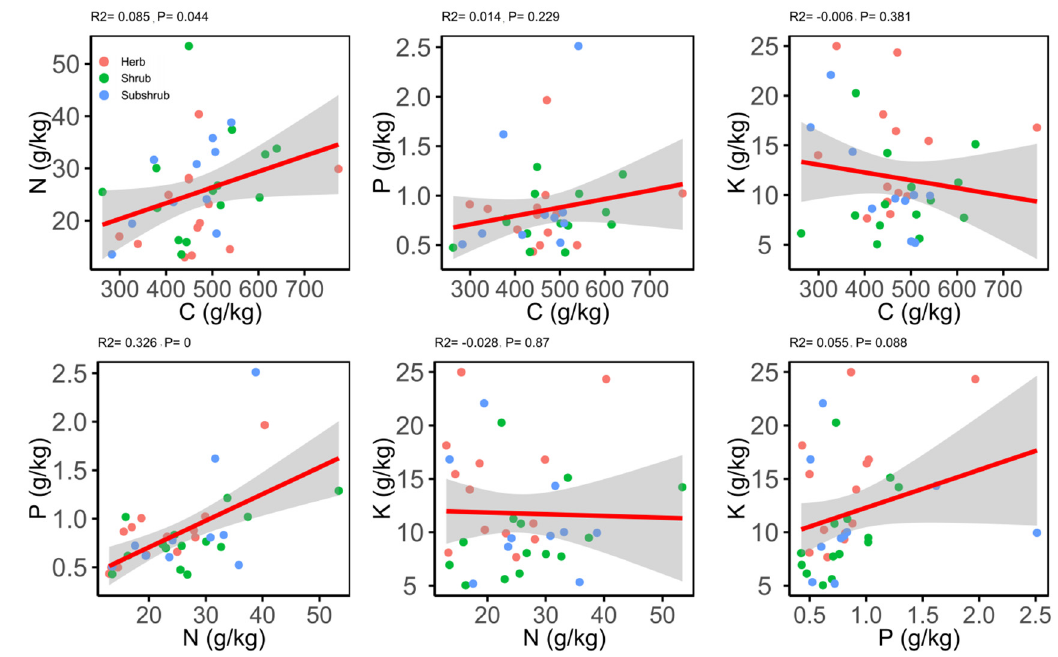
Figure 3. Relationship between different chemical traits of the leaf.